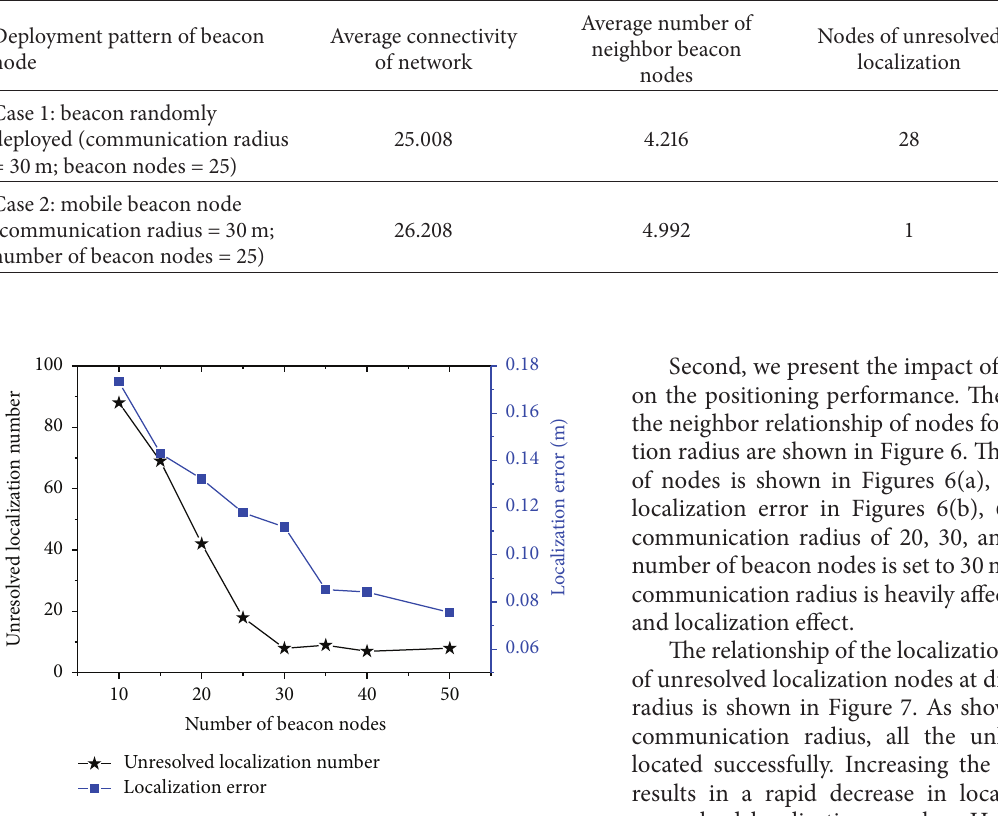
Figure 5: Relationship between localization effect and number of beacon